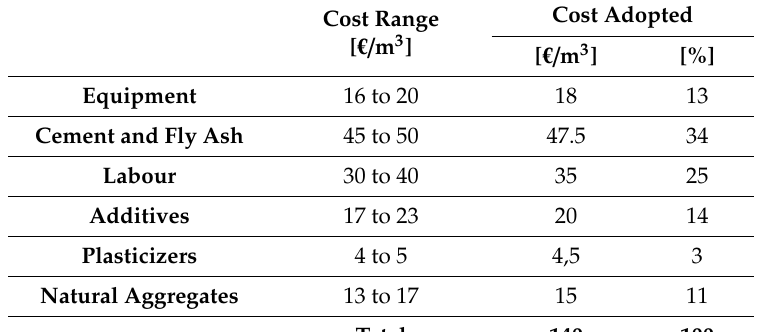
Table 8. Material costs per m 3 of dry-mix shotcrete produced.